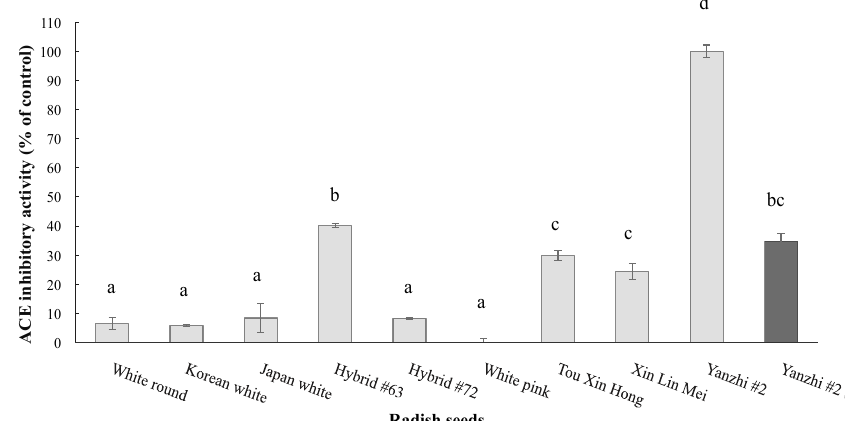
Fig. 2: ACE inhibitory activities of antioxidant extracts of radish seeds. ACE inhibitory activity was measured from 1-ml extracts obtained from 2 mg of seed flour except for Yanzhi #2 (5D), which had a five-fold dilution. Tests were conducted in triplicate. Vertical lines represent standard deviations. Columns marked with different letters are significantly different (p<0.05).